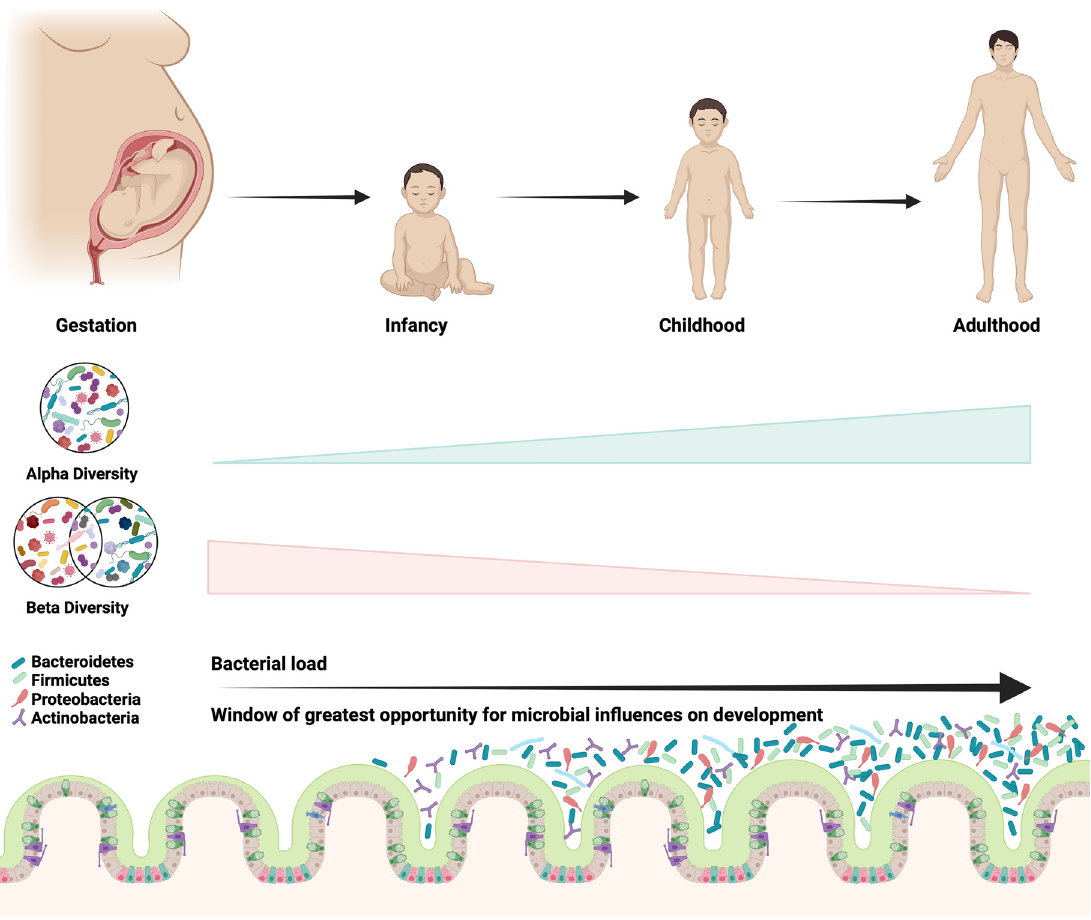
Figure 2: Microbial changes from gestation to